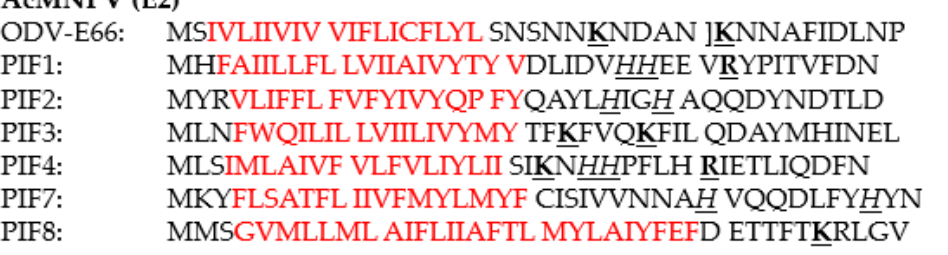
Figure 2. Comparison of the N-terminal transmembrane domains of PIF1, PIF2, PIF3, PIF4, PIF7 and PIF8 with the inner-nuclear membrane sorting motif of ODV-E66. In red: the hydrophobic region; in bold and underlined: the positively charged amino acids lysine ( K ) and arginine ( R ); in italic and underlined the amino acid histidine ( H ) which is only positively charged when protonated.